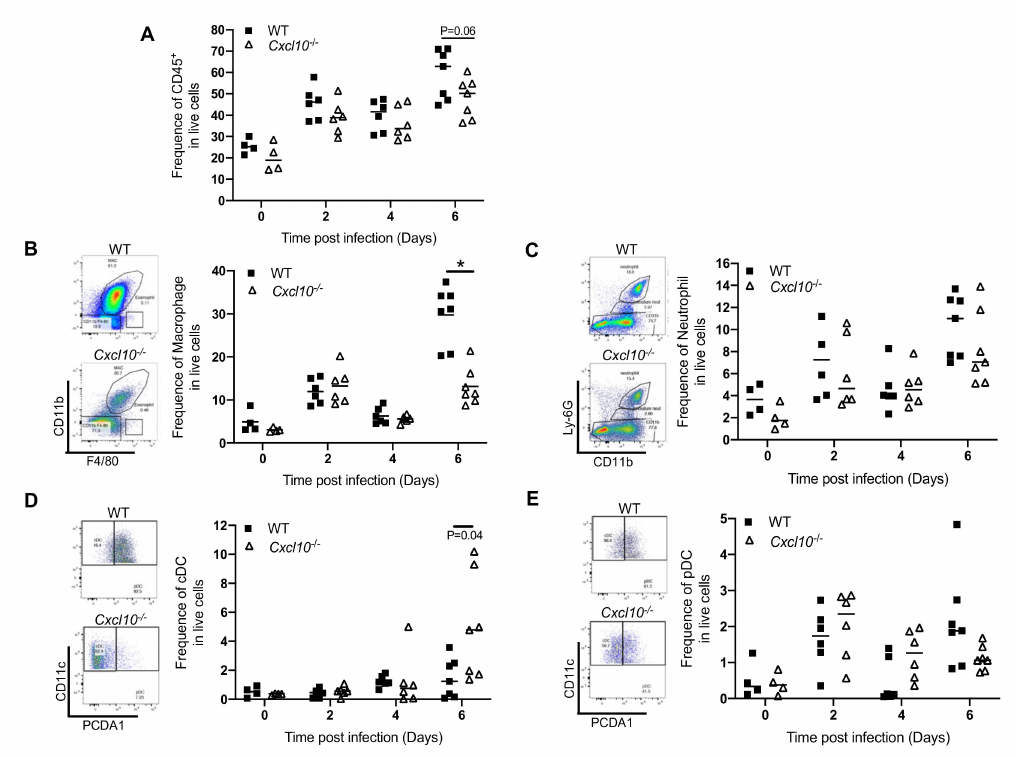
Figure 4. CXCL10 signaling facilitates macrophage infiltration into mouse feet. Age- and sex-matchedC57BL / 6 (WT) and Cxcl10 -deficient ( Cxcl10 − / − ) mice were infected with ONNV. Di ff erent immune cells were quantitated by fluorescence activated cell sorting (FACS). The frequencies of ( A ) the total number of CD45 + immune cells, ( B ) CD11b + F4 / 80 + macrophages, ( C ) CD11b + Ly-6G + neutrophils, ( D ) CD11c + MHCII + conventional dendritic cells (cDC), and ( E ) CD11c + PCDA1 + plasmacytoid dendritic cells (pDC). Each dot = one mouse. The horizontal line in each column = the median. * p < 0.05 (non-parametric Mann-Whitney t